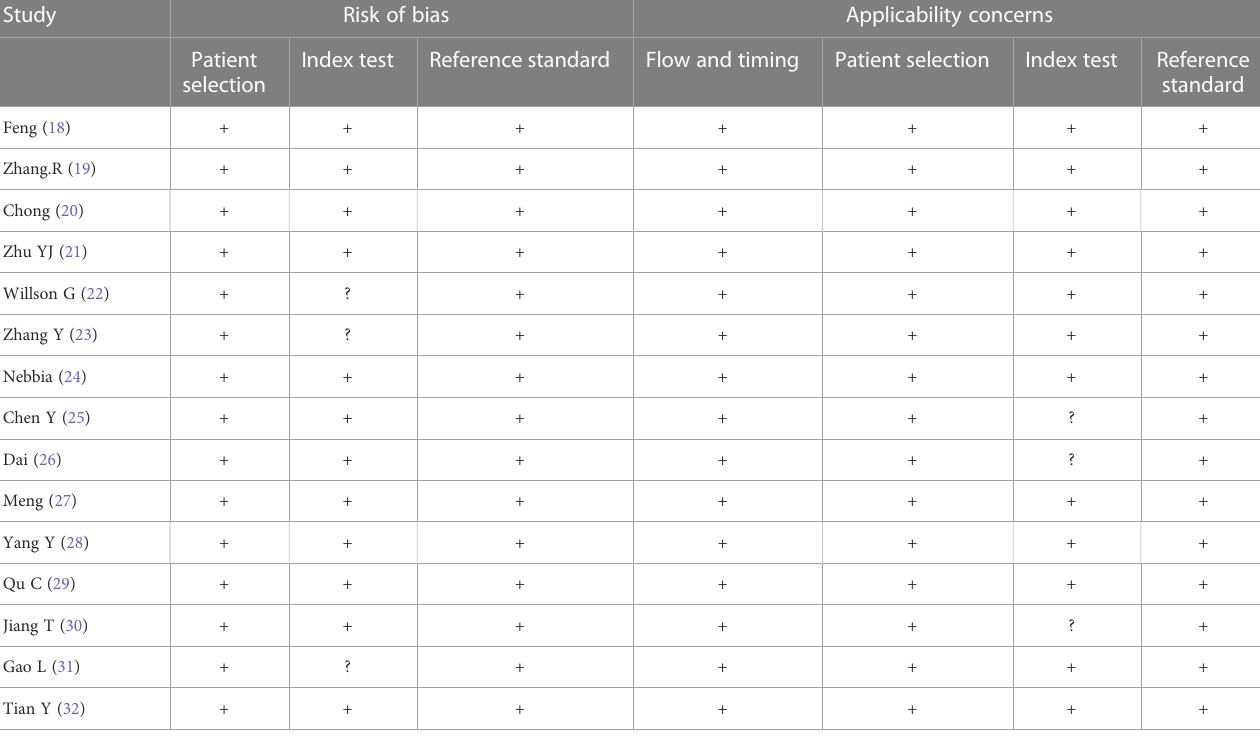
TABLE 3 Results of the Quality Assessment of Diagnostic Accuracy Studies 2 (QUADAS-2) quality assessment of included studies. Study